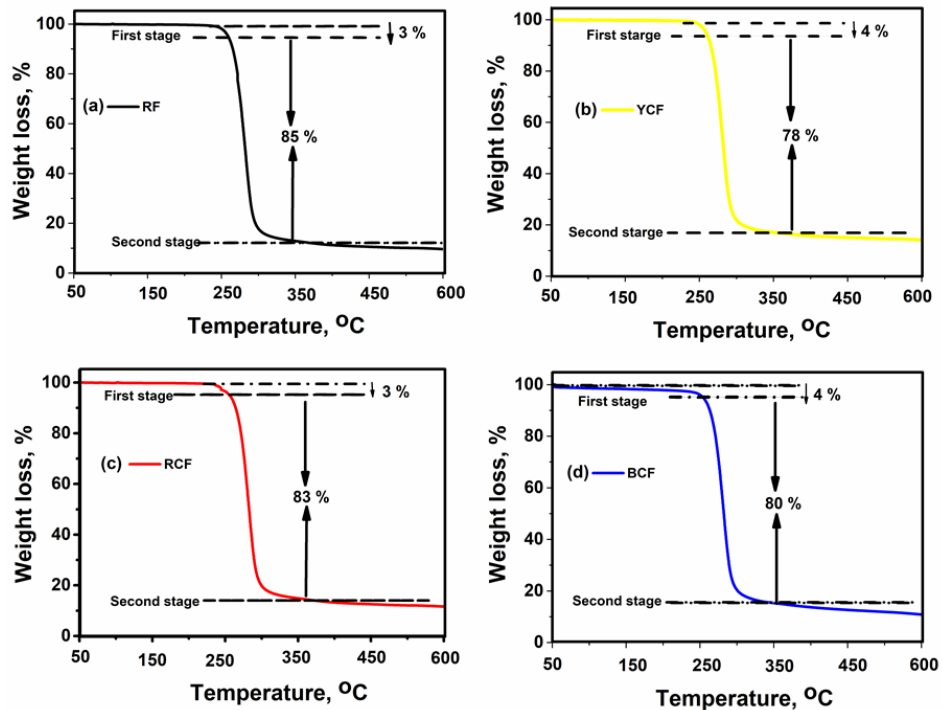
Figure 6. TGA curves of: ( a ) RF; ( b ) YCF; ( c ) RCF; and ( d ) BCF.